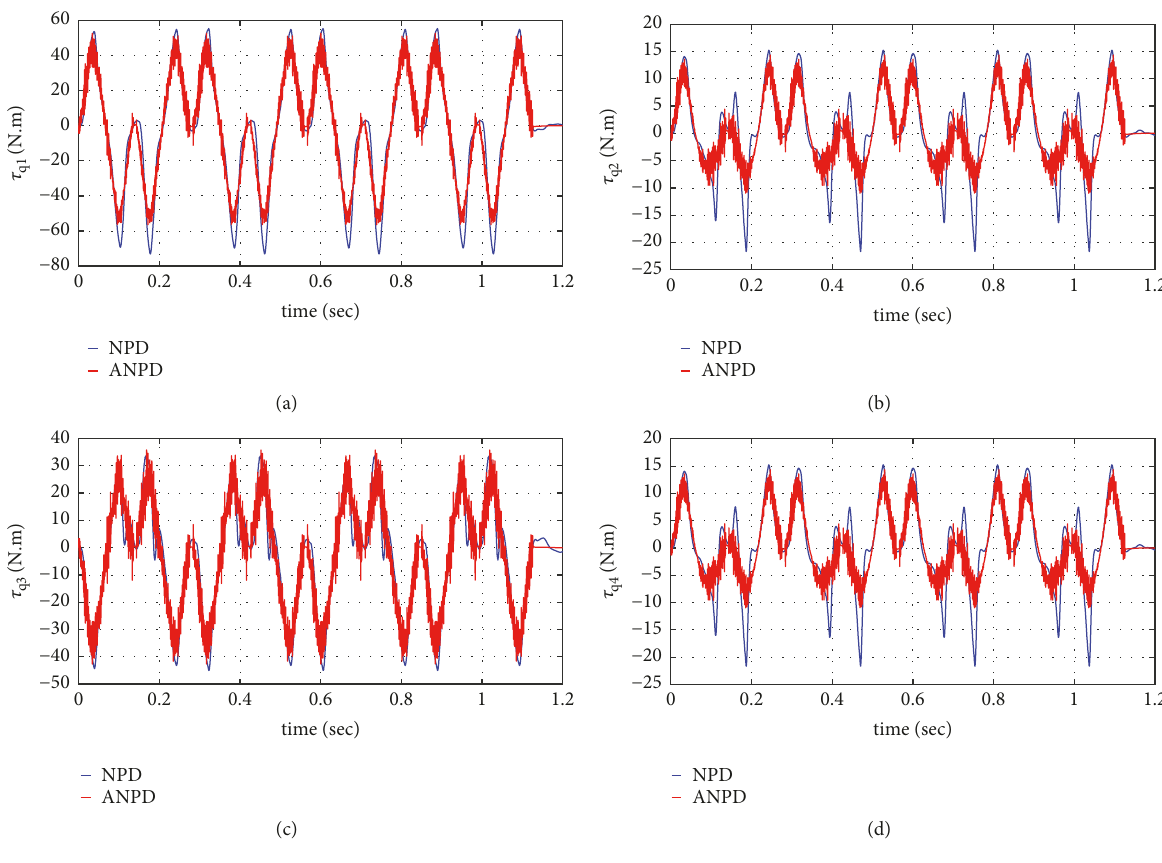
Figure 12: Torque responses for NANPD and ANPD controllers.